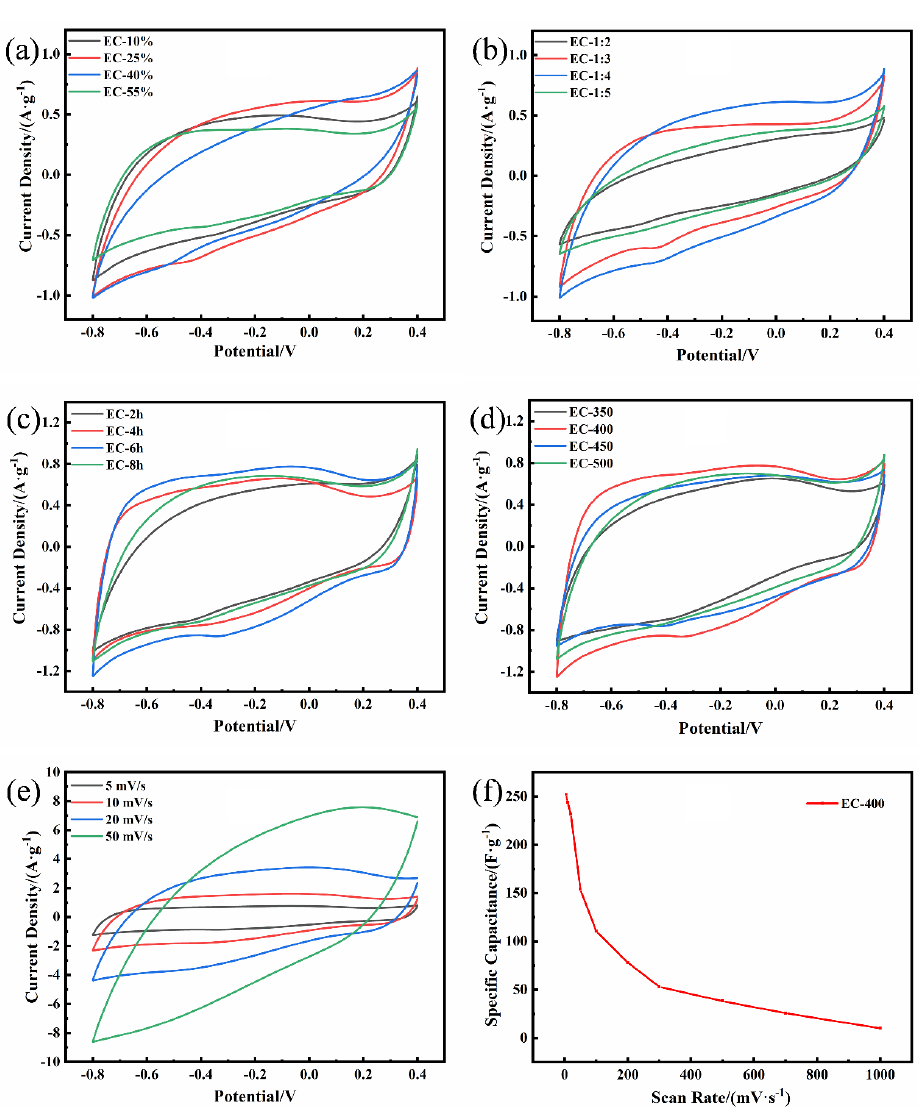
Figure 5. ( a – d ) The CV curves of ECs at 5 mV · s − 1 ; ( e ) the CV curves of EC-400 at different scan rates; ( f ) the specific capacitance of EC-400 at different scan rates.